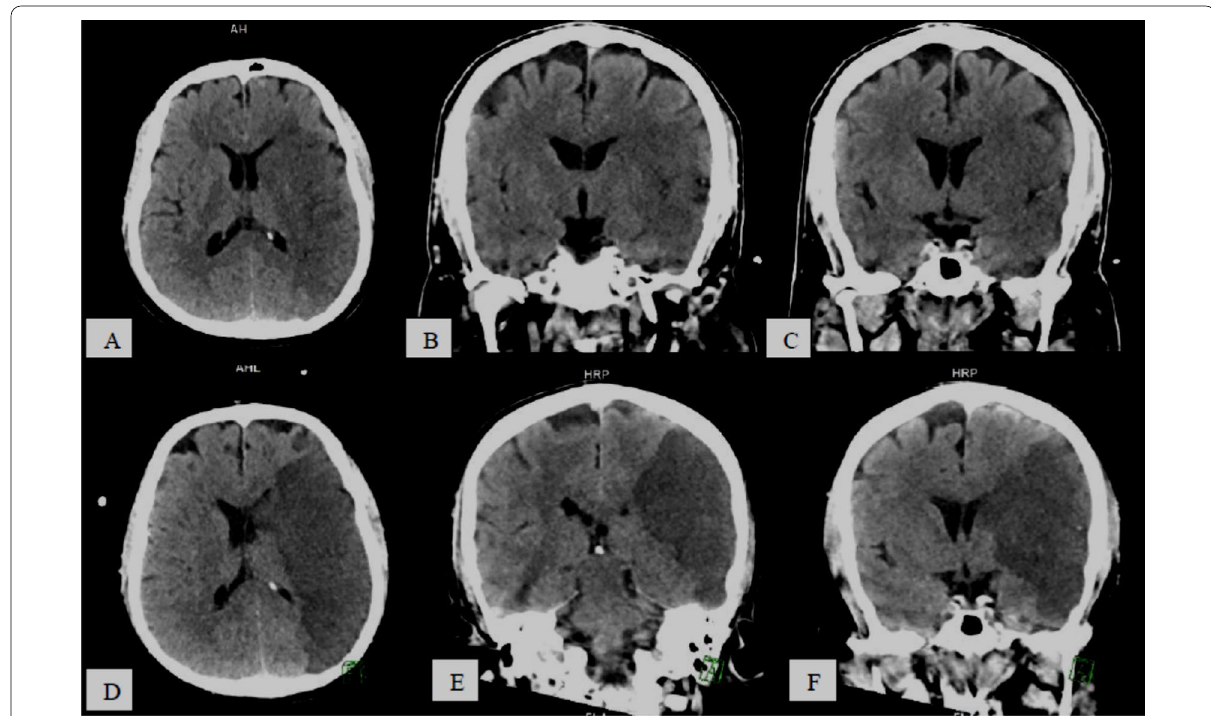
Fig. 1 58-year-old COVID-19 male patient with right-sided weakness and impaired level of consciousness, A–C serial axial and coronal reformatting CT brain study without contrast, showing large ill-defined left fronto-temporo-parietal cortical and subcortical hypodense area with mild mass effect in form of effacement of cortical sulci and ispilateral lateral ventricle. D–F serial axial and coronal reformatting CT brain study follow-up after 1 day shows massive progressed left fronto-temporo-parietal acute non-hemorrhagic infarction (left MCA territory) with increase mass